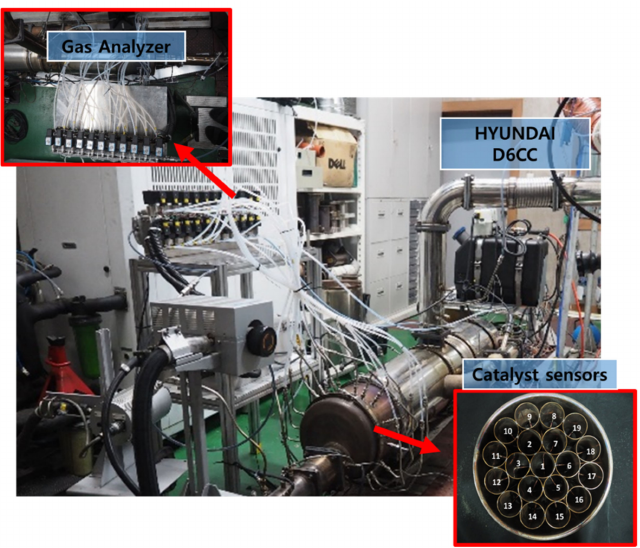
Figure 33. Sampled ammonia values in the catalyst inlet adapted from Khristamto et al.